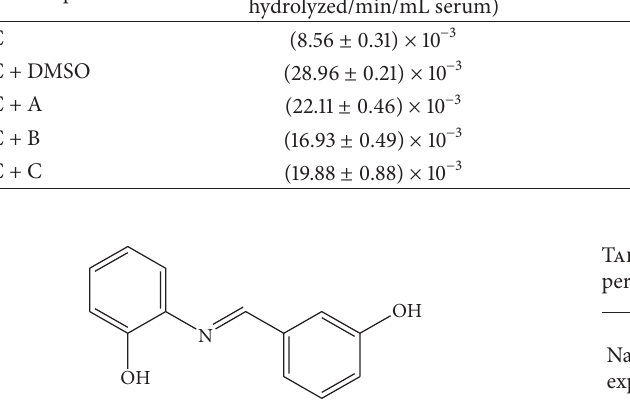
Figure 2: (3-Hydroxy-benzylidene)-(2-hydroxy-phenyl)-amine (SB-2). Yield: 3.1 g (82%). Anal. Calc. (%): C, 73.2; H, 5.2; N, 6.6. Found: C, 73.0; H, 5.2; N, 6.5. M.p. 160–162 ∘ C.